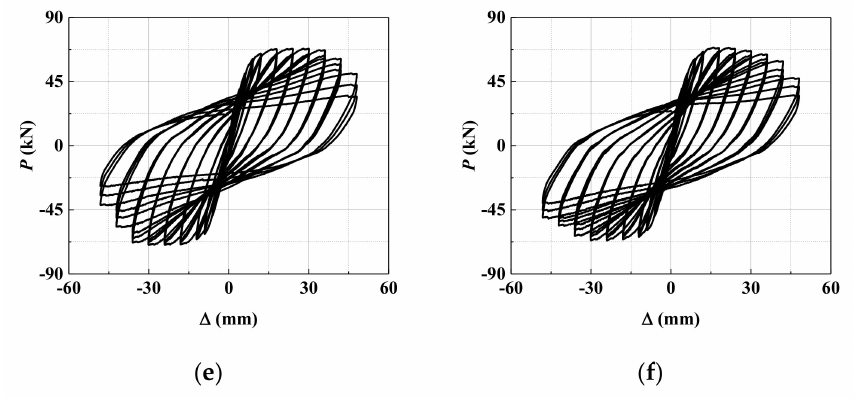
Figure 24. Hysteresis characteristics of the specimens. ( a ) JP-F0. ( b ) JP-F1. ( c ) JP-F2. ( d ) JP-F3. ( e ) JP-F4. ( f ) JP-F5.